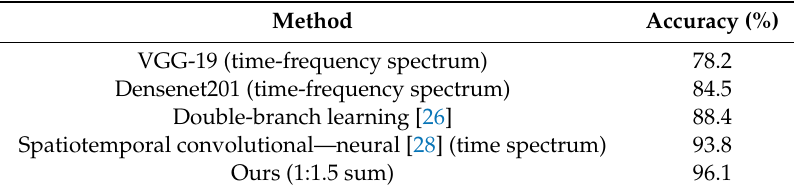
Table 5. According to the data of this task, several mainstream models are tested.